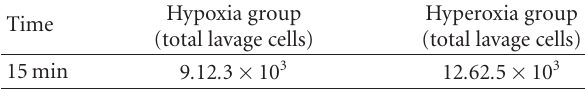
group, but not in the saline or milk groups (Figure